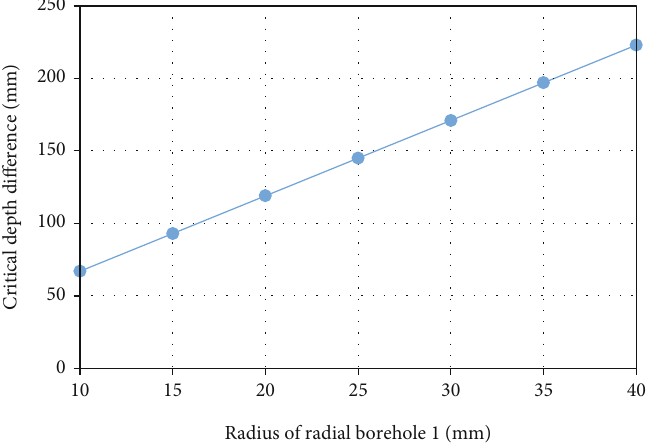
Figure 13: Critical depth di ff erence with di ff erent radius of radial borehole 1.